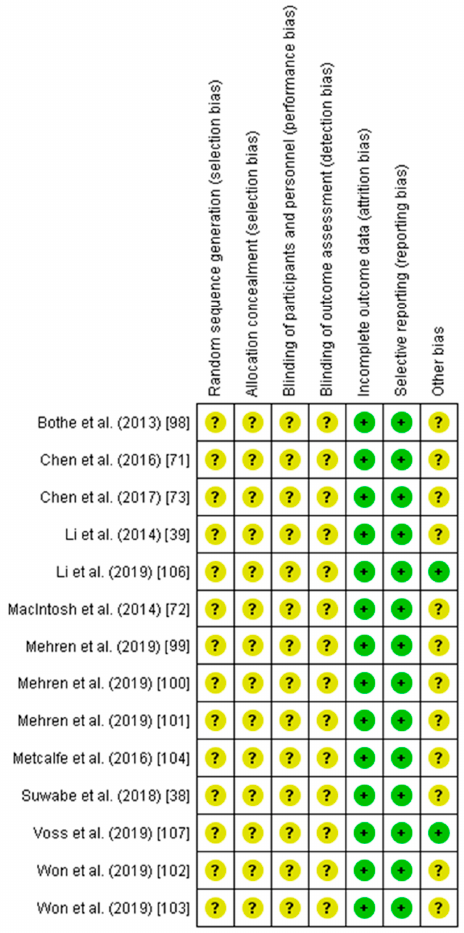
Figure 3. Illustration of the analysis of the risk of bias assessment of the included studies. This figure was created by using Review Manager [98] and follows the recommendations outlined in the Cochrane Collaboration guidelines [97]. A “green plus” indicates a low risk of bias and a “yellow question mark” indicates an unclear risk of